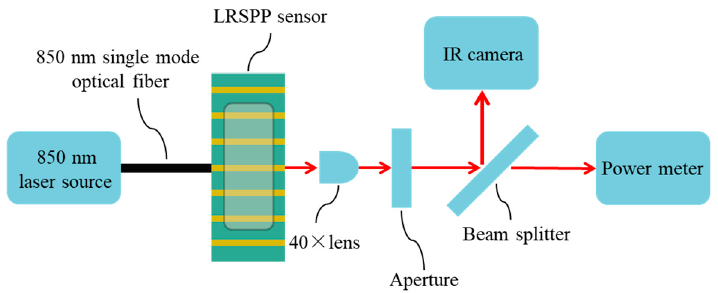
Figure 12. Schematic diagram of setup for characterizing LRSPP waveguide sensors.